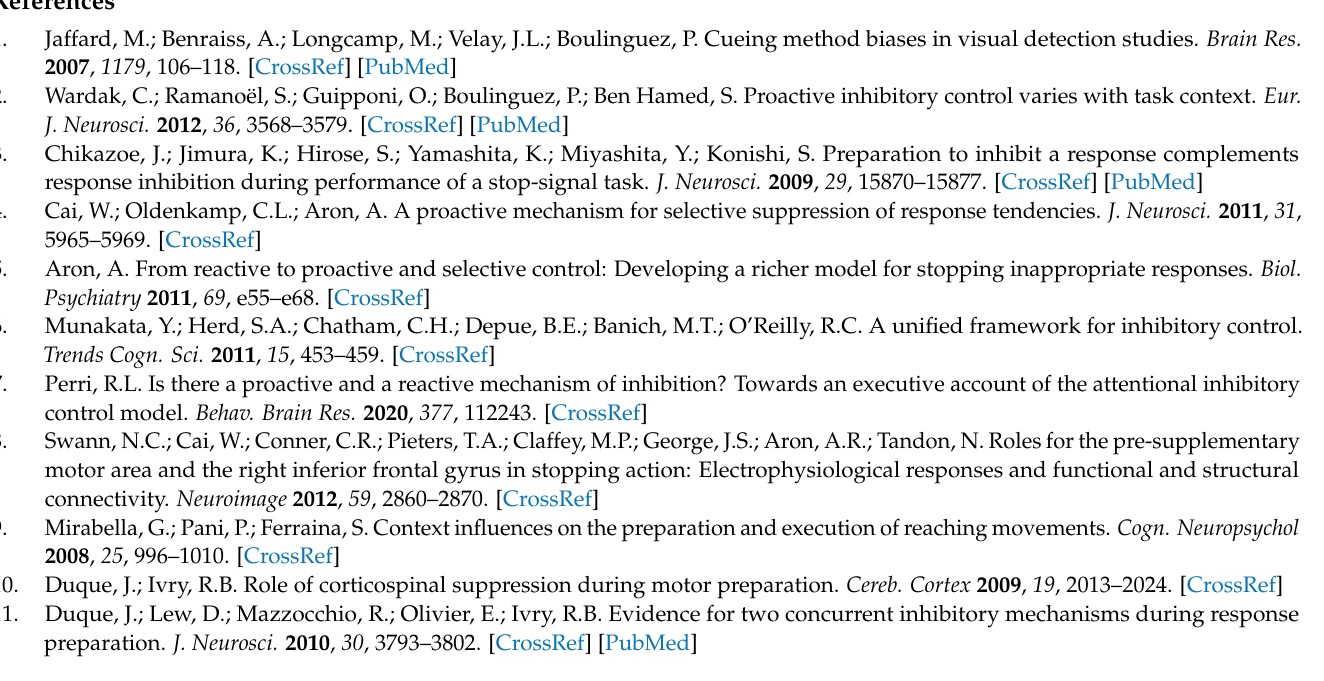
S2: Distribution data for correct and incorrect responses, Figure S3: Cue-triggered motor preparation, Figure S4: Valid cue trials: correlation between the cumulative amplitude of correct cue-triggered EMG activity measured in the cue-target period and RTs, Figure S5: Invalid cue trials: correlation between the latency of cue-triggered EMG activity measured in the cue-target period and